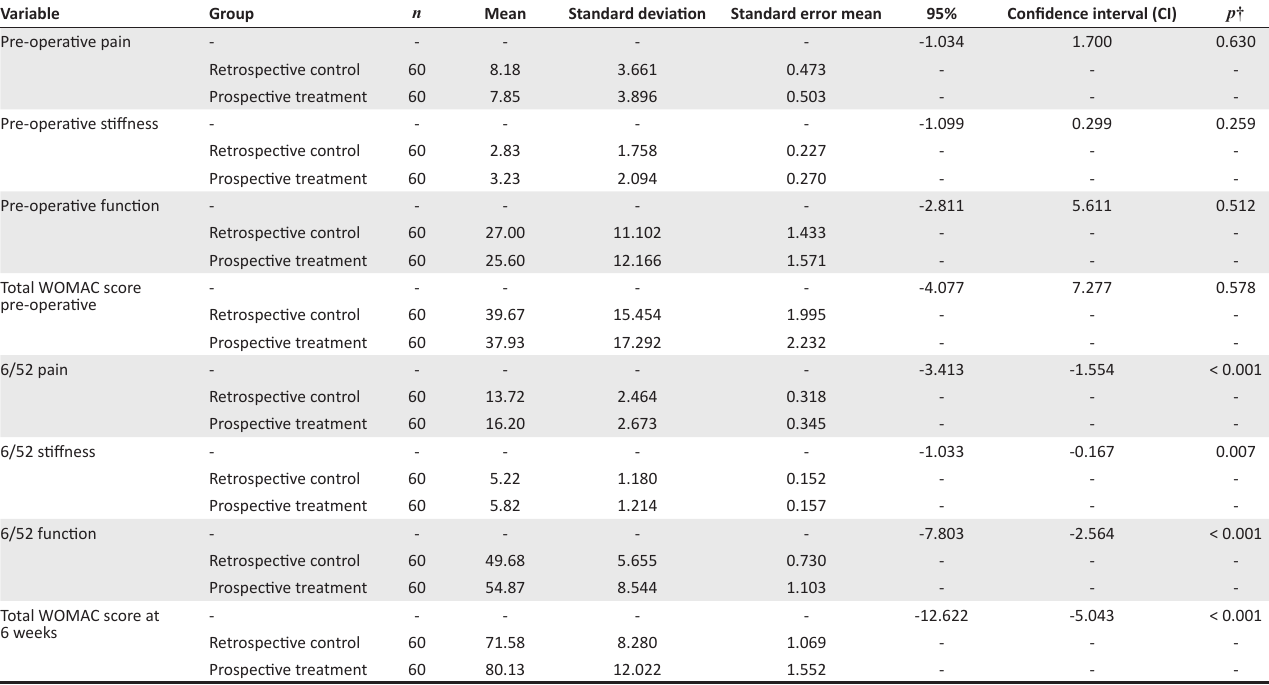
TABLE 4: Comparison of patient reported outcome Western Ontario and McMaster Universities Osteoarthritis index between groups ( n = 120). Variable